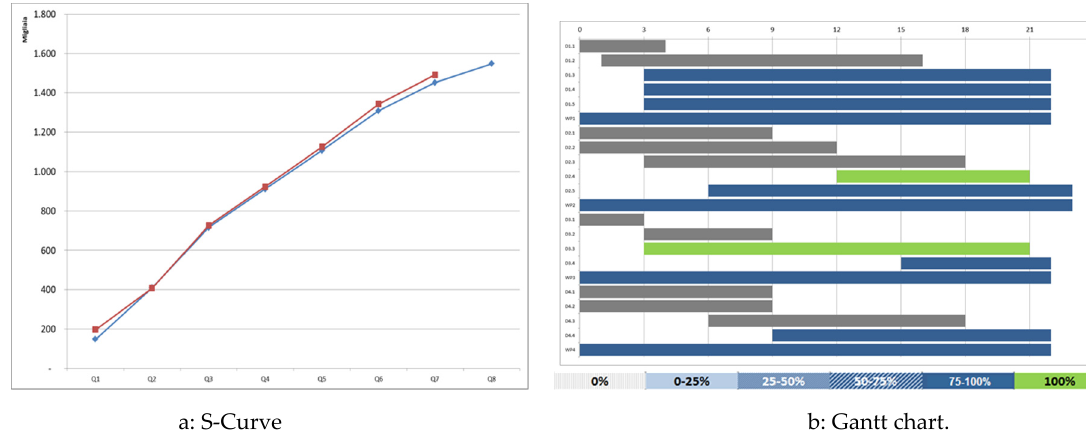
Figure 5. Innovative Electric Generation (GEI).